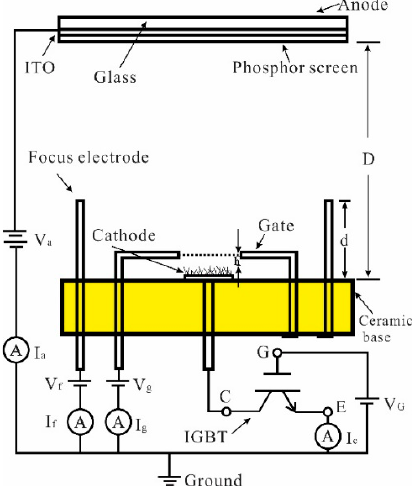
Figure 1. The structure and measurement circuit of CNTs cold cathode electron gun.